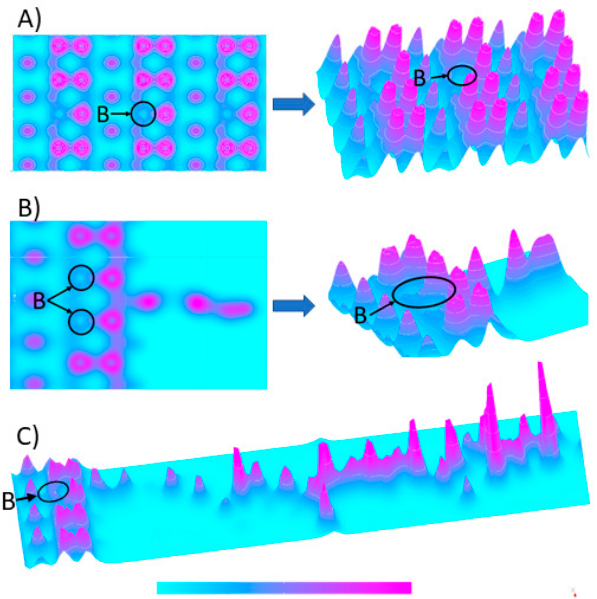
Figure 2. Electron density iso-surfaces: ( A )—(BDDE) relaxed boron-doped diamond (111) slab; ( B )—(BDDE-H-ABA)-H-terminated reconstructed boron-doped diamond (111) with adlayer of 4-aminobenzoic linker, ( C ) (BDDE-H-ABA-C3H)—BDDE modified with 4-aminobenzoic linker bonded to C3H ligand of the anti-M1 antibody protein. Azure colour defines electron density close to zero, and the purple describes values up to 1.